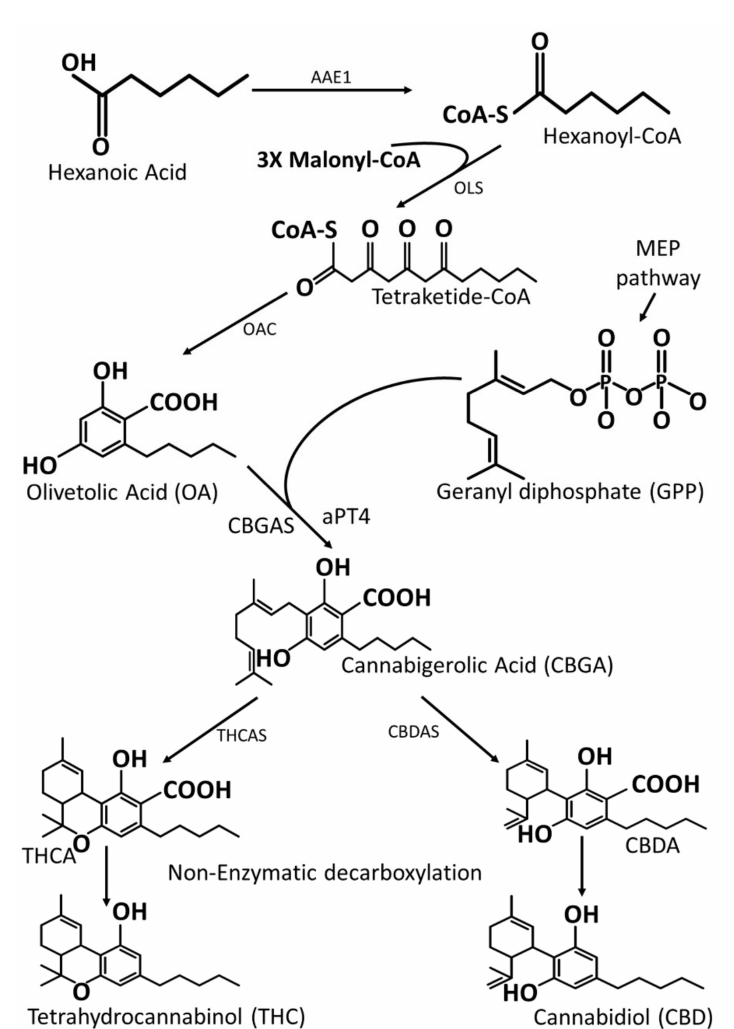
Figure 7. A simplified overview of phytocannabinoids’ biosynthesis in Cannabis using THC and CBD as representative molecules. The phytocannabinoid acids in Cannabis are enzymatically synthesized from one precursor molecule, CBGA. CBGA is derived from MEP and polyketide pathways under the mediation of CBGA and aPT4 enzymes. AAE1, Acyl-activating enzyme 1; OLS, olivetol synthase; OAC, olivetolic acid cyclase; CBGAS, cannabigerolic acid synthase; aPT4, aromatic prenyltransferase 4; THCAS, tetrahydrocannabinolic acid synthase; CBDAS, cannabidiolic acid synthase; THCA, tetrahydrocannabinolic acid; CBDA, cannabidiolic